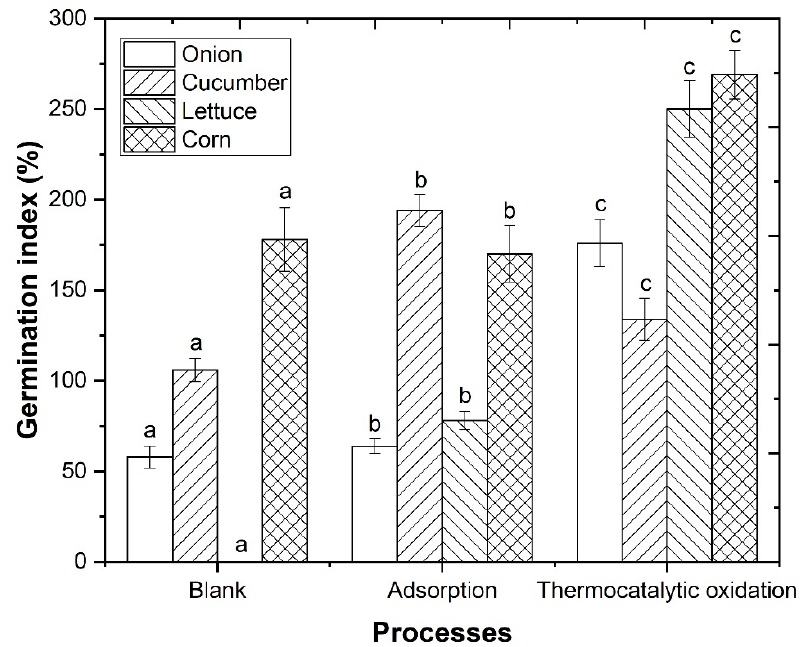
Figure 10. Analysis of seed phytotoxicity after wastewater treatment, by evaluation of germination index (GI). Adsorption operational conditions, as follows: [Na-Mt] = 5.0 g/L, pH = 3.0, V = 500 mL, agitation 350 rpm, T = 298 K, t = 24 h. Thermocatalytic oxidation conditions, as follows: S 2 O 8 2 - /H 2 O 2 ratio = 1:0.25, S 2 O 82 - /H 2 O 2 dosage = 0.1:0.025 ( g/g ), pH = 7.0, T = 343 K, agitation 350 rpm, t = 2 h. GI ≤ 50% (high concentration of phytotoxic substances), 80% < GI > 50% (moderated presence of phytotoxic substances), GI ≥ 80% (there are no phytotoxic substances, or they exist in very small dosages). Means in bars with different letters represent significant differences ( p < 0.05) between each process (blank, adsorption and thermocatalytic oxidation) by comparing different plant seeds.